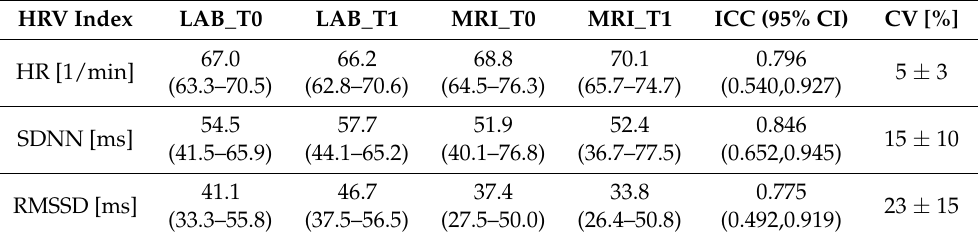
Table 4. HRV indices derived from repeated recordings of electrocardiograms in the laboratory and photoplethysmogram during MRI (N =